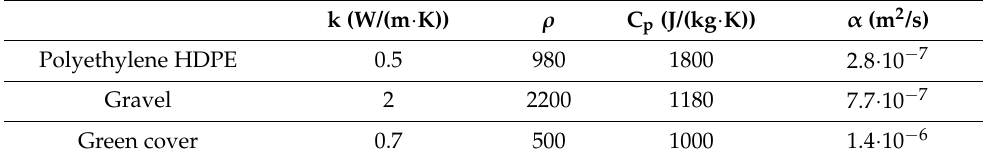
Table 1. Thermophysical properties for material covers, thermal conductivity (k), density ( ρ ), specific heat capacity (C p ), and diffusivity ( α ). Data taken from “Codigo T é cnico de la Edificaci ó n” for polymer and gravel [24] and Olivieri et al. for a reference green cover [25], and presented as indicative